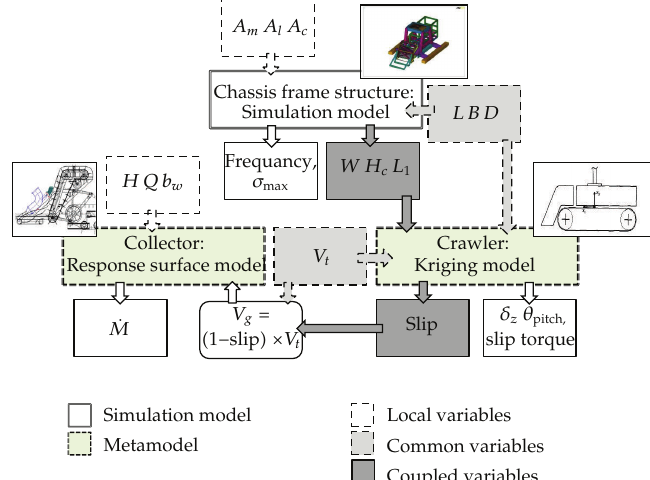
Figure 8: Coupled relations and variables of each subsystem of the test